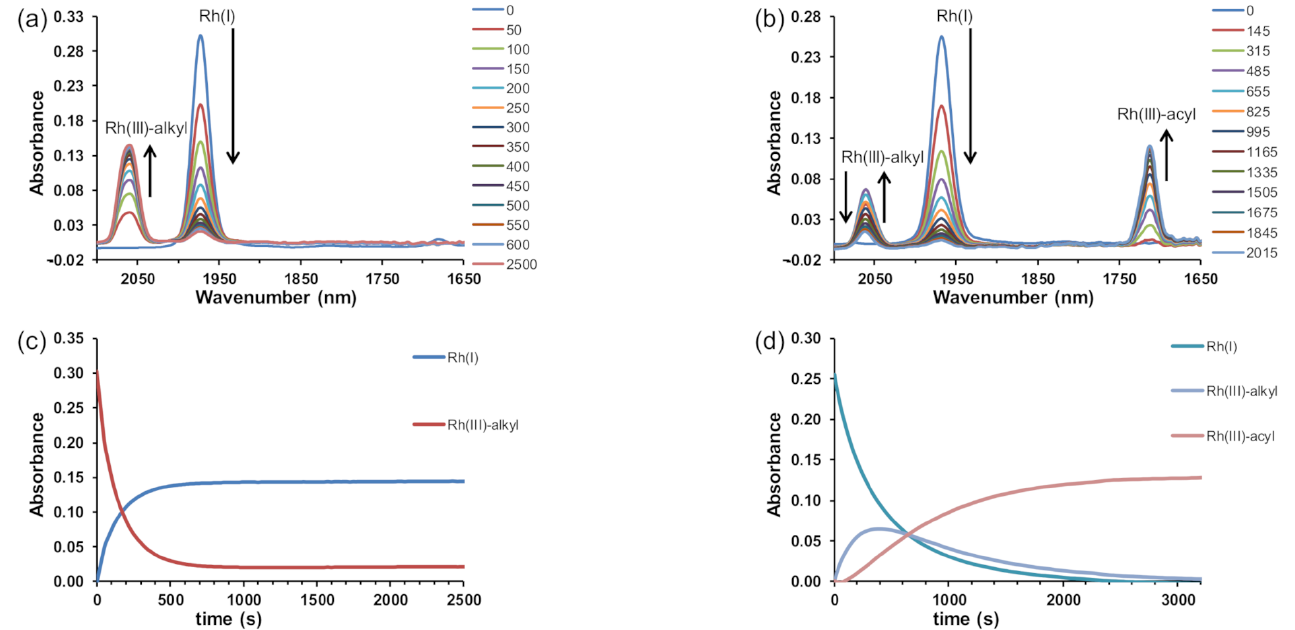
Figure 3. IR spectra of the reaction between ( a ) [Rh(CH 3 COCHCNPhCH 3 )(CO)(PPh 3 )] 3B and 0.0272 mol dm − 3 CH 3 I and ( b ) [Rh(CH 3 COCHCNHCH 3 )(CO)(PPh 3 )] 3A and 0.0537 mol dm − 3 CH 3 I, both at at 25 ◦ C, with the CH 3 I concentration at 10 × excess, with respect rhodium concentration at the indicated time in s. ( c ) The [Rh(CH 3 COCHCNPhCH 3 )(CO)(PPh 3 )] 3B + CH 3 I reaction, as monitored at 1973.62 and 2059.72 cm − 1 , with time. ( d ) The [Rh(CH 3 COCHCNHCH 3 )(CO)(PPh 3 )]